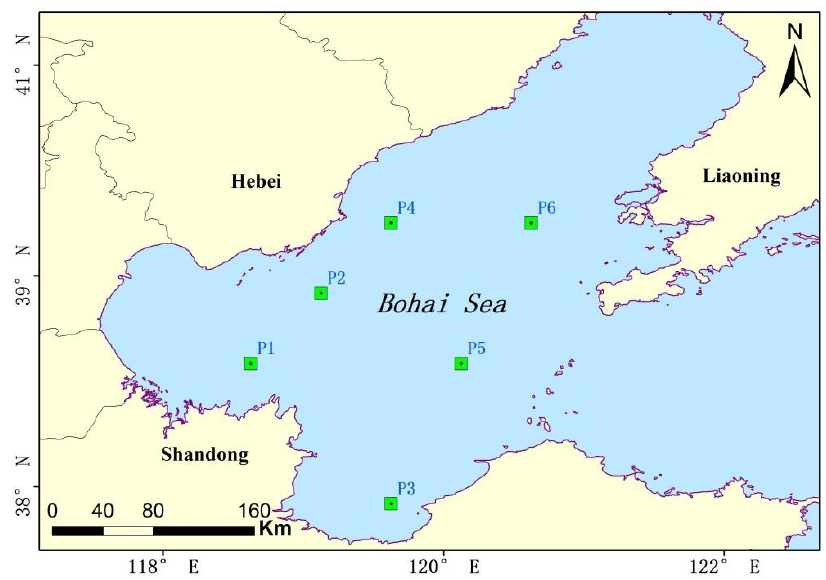
Figure 1. Study area in the Bohai Sea. The six selected sites are as follows: P1 (118.625°E, 38.375°N), P2 (119.125°E, 38.875°N), P3 (119.625°E, 37.375°N), P4 (119.625°E, 39.375°N), P5 (120.125°E, 38.375°N), and P6 (120.625°E, 39.375°N).